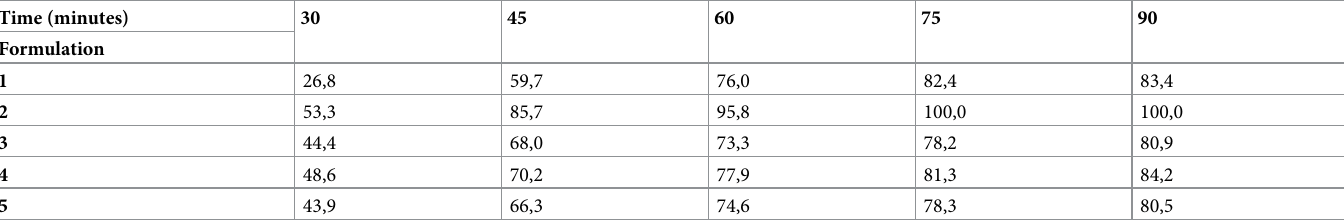
The solution used for this experiment is 3% SDS aqueous